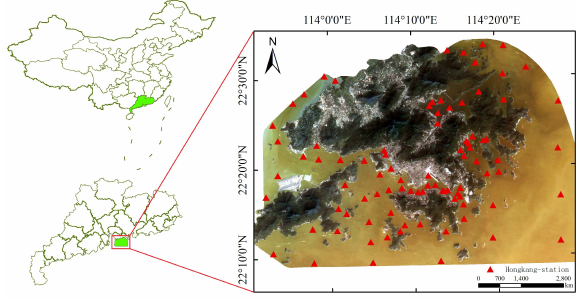
Figure 1. Study area and stations